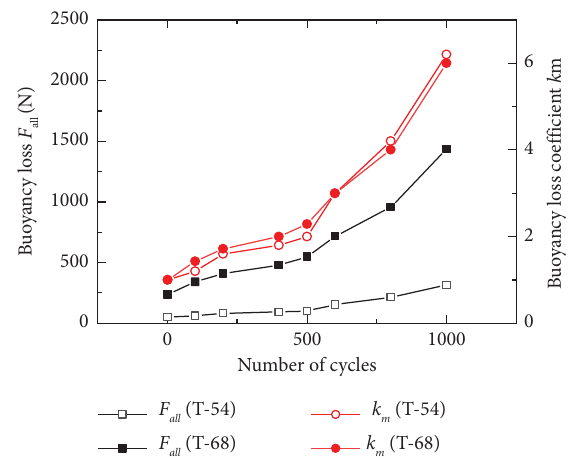
Figure 17: Cyclic load times vs. buoyancy